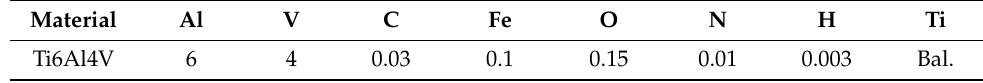
Table 2. Chemical composition of the Ti6Al4V plate (wt%).